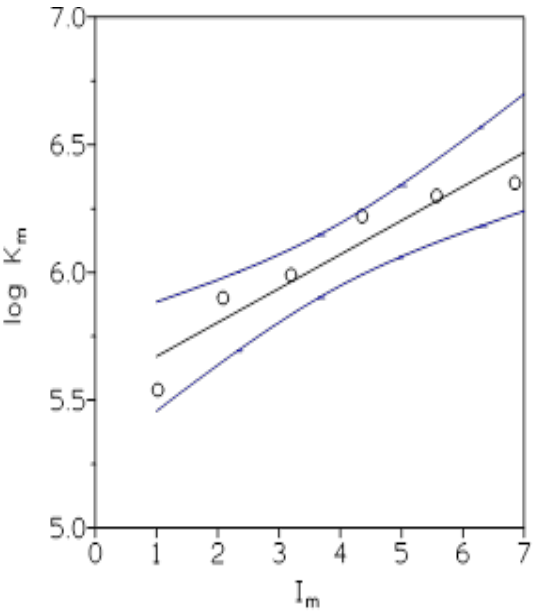
Figure 5. Plot of log K m versus I m . Dotted lines show 95% confidence interval of the regression line.